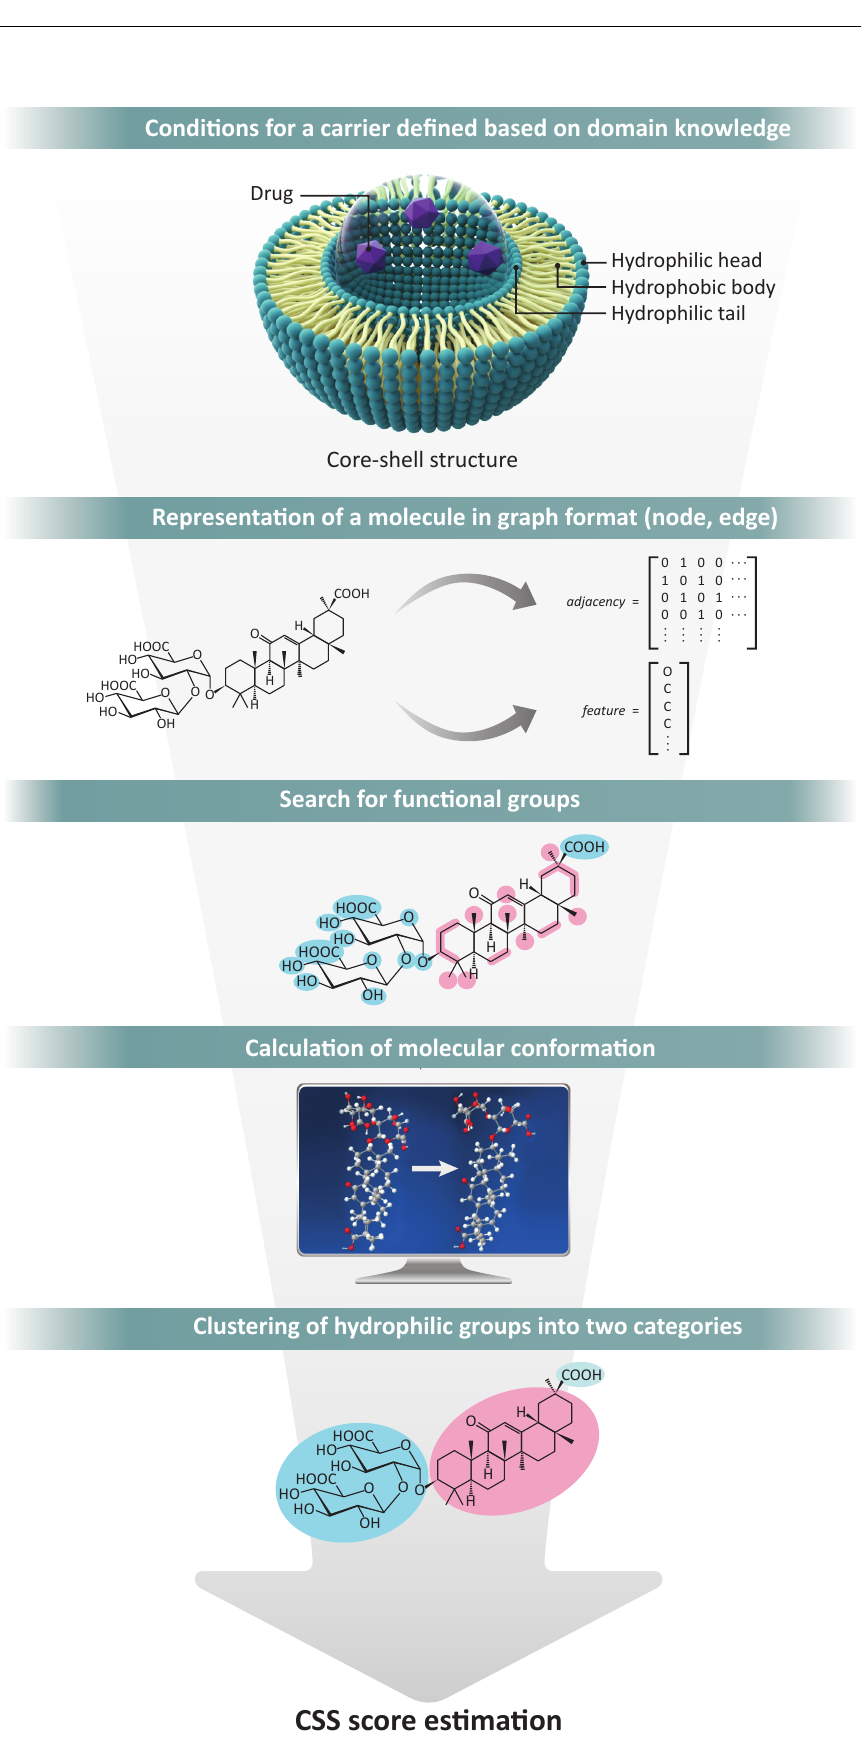
Figure 7. Total process of the CSS